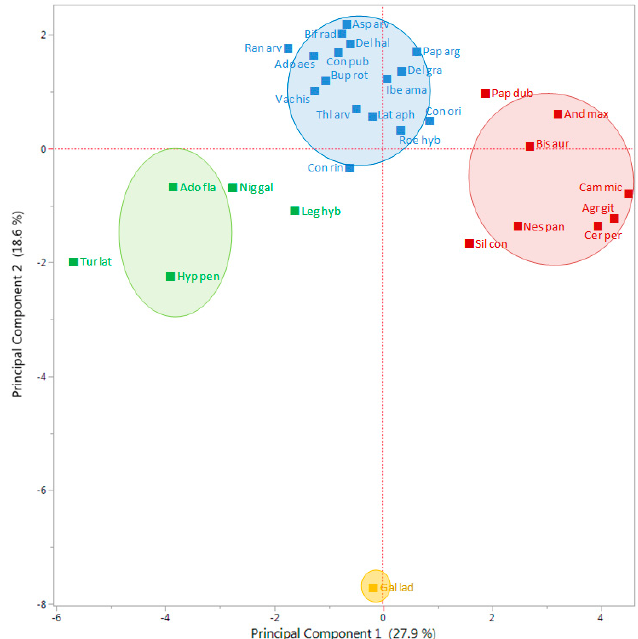
Figure 4. Biplot representation of K-means clustering using the first two PC of the PCA for 30 RAP species (three first letters of the genus and species) according to their emergence patterns in two trials (S1 and S2) during three consecutive seasons. There were two burial conditions considered in the analysis: 1 cm burial depth without soil disturbance and 1–10 cm depth with annual autumnal soil disturbance. Percentages in parenthesis represent the variability explained by each PC. Circles, ellipses and names with the same colors include the species within each of the groups derived from a K-means clustering of the ordination scores. The full species names are given in Table 2.